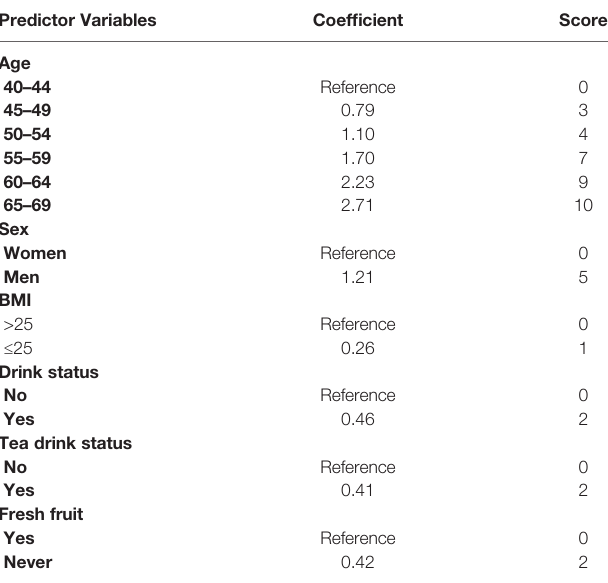
TABLE 5 | Coef fi cient of predictor variables from prediction model and its corresponding score. Predictor